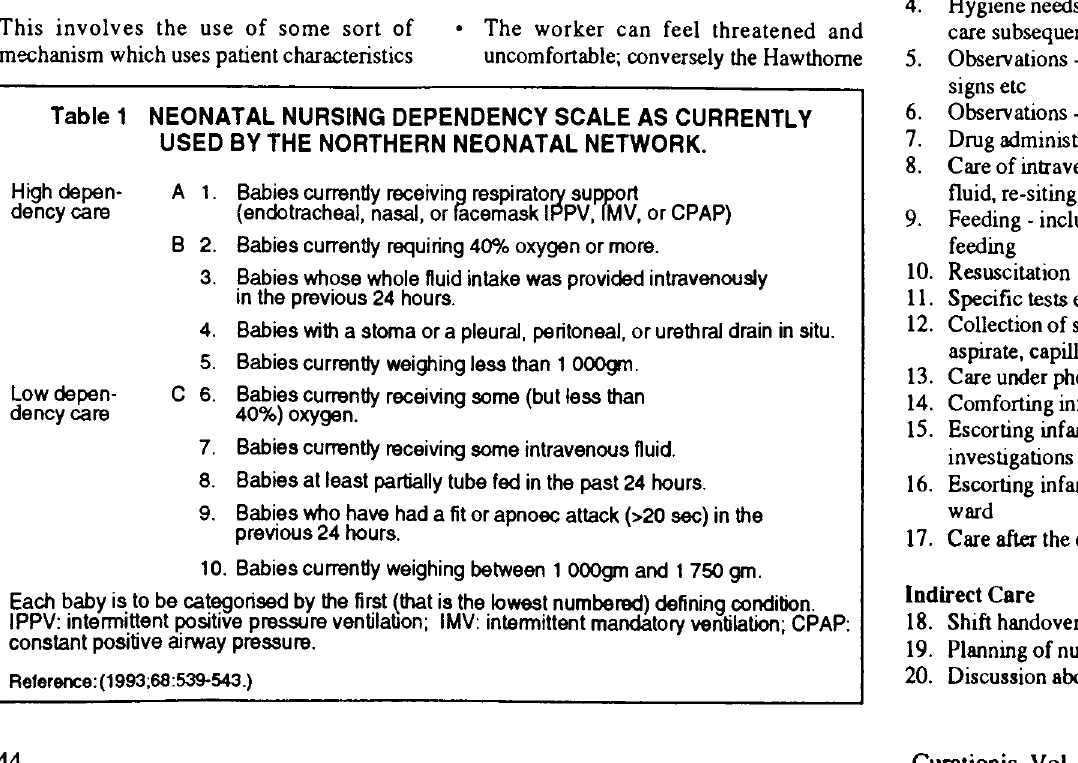
Table 1 NEONATAL NURSING DEPENDENCY SCALE AS CURRENTLY USED BY THE NORTHERN NEONATAL